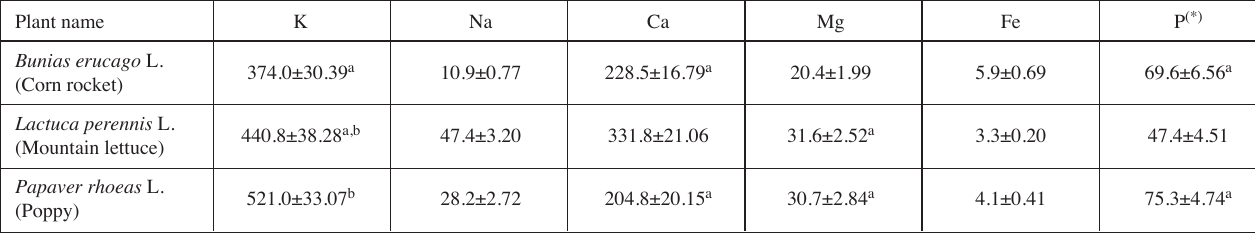
Tab. 3: Mineral content of raw edible wild plants (g/100g edible weight).